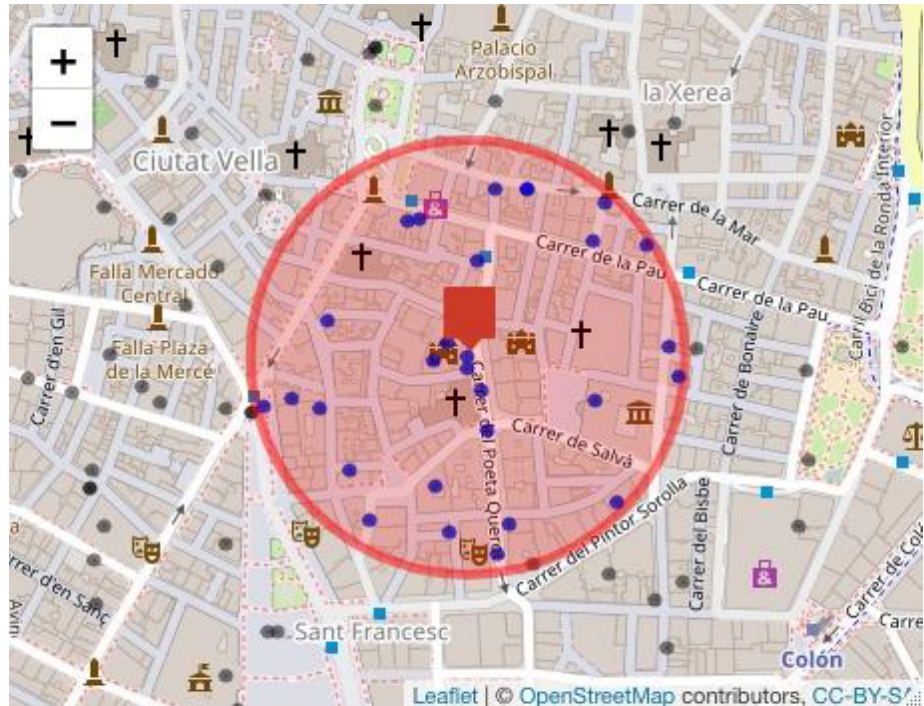
Figure 3. Higher risk cluster. The policyholders located within a 200 m radius (Haversine distance is used). Interactive map available at: https://go.uv.es/vcoll/cumulus_2 (accessed on 31 May 2021).